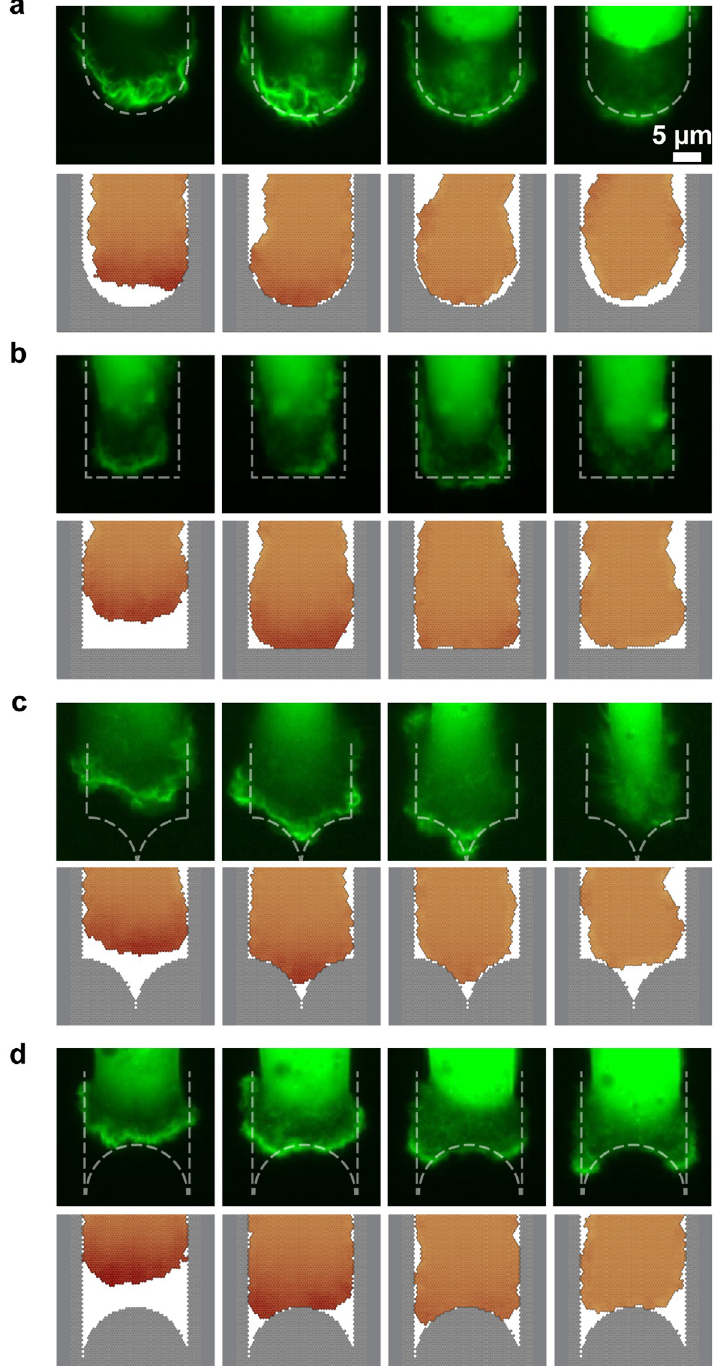
Fig 7. Geometry dependence of migratory arrest. Comparison between LifeAct GFP labeled MDA-MB-231 cells and simulated cells, which migrate towards differently shaped microlane tips (Lane length L = 170 μ m, width W = 20 μ m, 5 min time intervals). The top row (in green) shows fluorescence time-lapse data, while the bottom row shows the corresponding computer simulation for ( a ) round-shaped tips ( b ) blunt-shaped tips ( c ) sharp-shaped tips and ( d ) concave-shaped